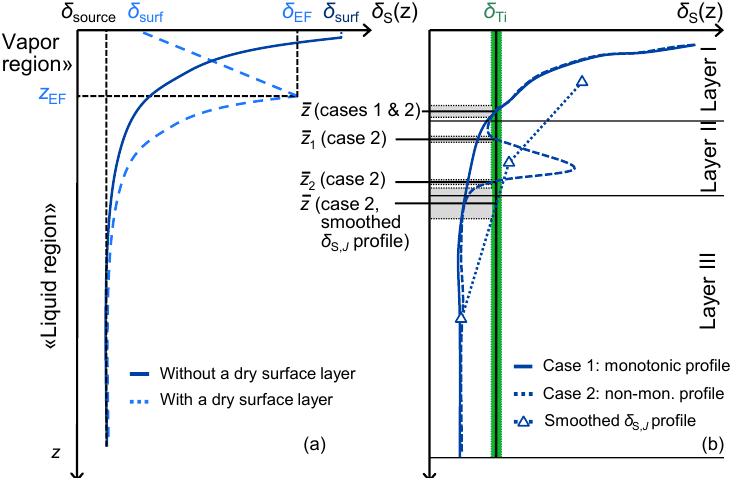
Figure 2. (a) Simulated soil water isotopic composition ( δ S ) profiles for a water saturated (dark blue line) and unsaturated (light blue dotted line) soil following Barnes and Allison (1983). Indices “surf” and “EF” refer to soil surface and evaporation front. “vapor” and “liquid” regions refer to soil regions where water flow occurs predominantly in the liquid and vapor phases, respectively. (b) Illustration of the graphical inference method for determining the mean root water uptake depth ( ¯ z) . “Ti” stands for the sap xylem water at the plant tiller. Case 1: one unique solution is found; case 2: more than one solution is found. A smoothed profile is designated by the symbols. The ¯ z range is indicated by the gray horizontal